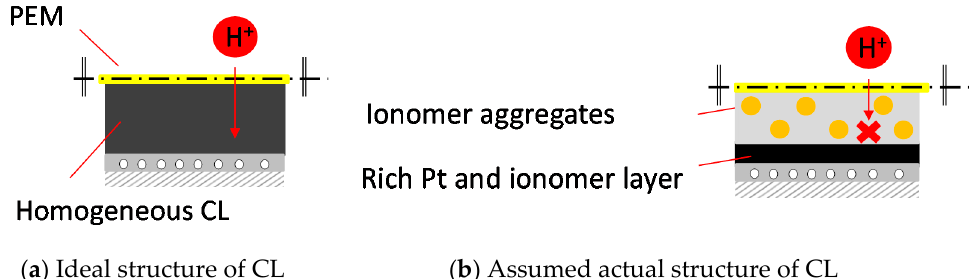
Figure 8. Schematic diagram of influence of number of layers on CL structure.